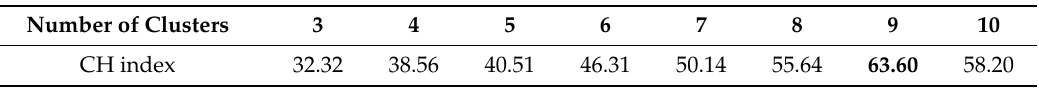
Table 4. CH index (Calinski–Harabasz) for each of the eight hypotheses of clustering. Number of Clusters